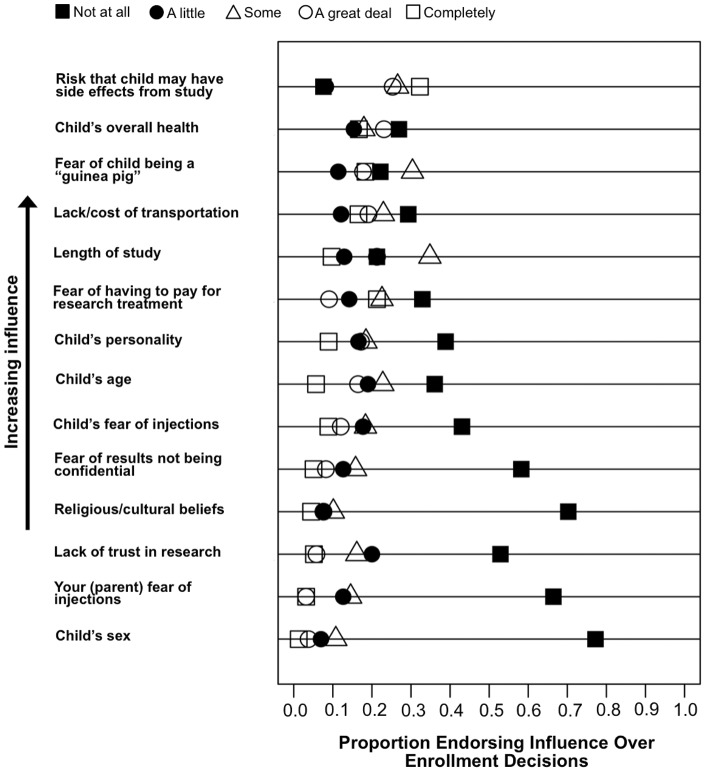
Parental responses to items probing factors that may influence decision to enroll a child in type 1 diabetes clinical trials (T1DCTs).Parents were asked: “There are lots of things that might affect a parent/guardian's decision to enroll a child in clinical trials. How much would the following influence your decision to enroll a child in a type 1 diabetes clinical trial?” Shapes correspond to endorsed degree of influence on a five-point Likert scale: black square  =  not at all, black circle  =  a little, white triangle  =  some, white circle  =  a great deal, white square  =  completely. The X-axis represents proportion of parents endorsing a specific level of influence.